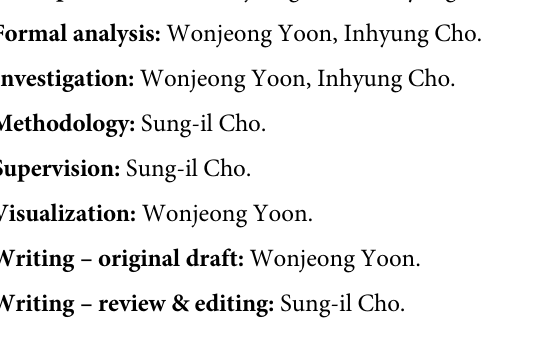
S2 Fig. The expanded classification of the stages of change in smoking cessation that reflects quit attempts. The stages of change (SOC) in smoking cessation cover the four quit- ting-related factors: (i) current behavior (current smokers; recent quitters); (ii) past-year quit attempt (yes; no), (iii) intention to quit (within the next 1 month; within the next 6 months; not within the next 6 months) and (iv) duration of quitting (6 months or less; more than 6 months). Compared to the traditional SOC model, the model proposed in this study is expanded to reflect past-year quit attempts. We isolated individuals who had not made a quit attempt in the past year from the ‘Precontemplation’ (PC) and ‘Contemplation’ (C) stages and set them as the ‘No attempt’ (NA) stage for the expanded SOC model. S1 Table. Prevalence of cessation stages by e-cigarette use status. Values are unweighted fre- quencies (N), weighted percentages (%), and P-values according to chi-square test. EC = e-cig- arette. S2 Table. Associations between e-cigarette use and current quitting behavior and the stages of change in smoking cessation (N = 3,929). Multivariate models were adjusted for all covariates and survey year. � P < 0.05; �� P < 0.01; ��� P < 0.001; Bold type P < 0.05. aOR = adjusted odds ratio; CI = confidence interval; EC = e-cigarette; Ref = reference.